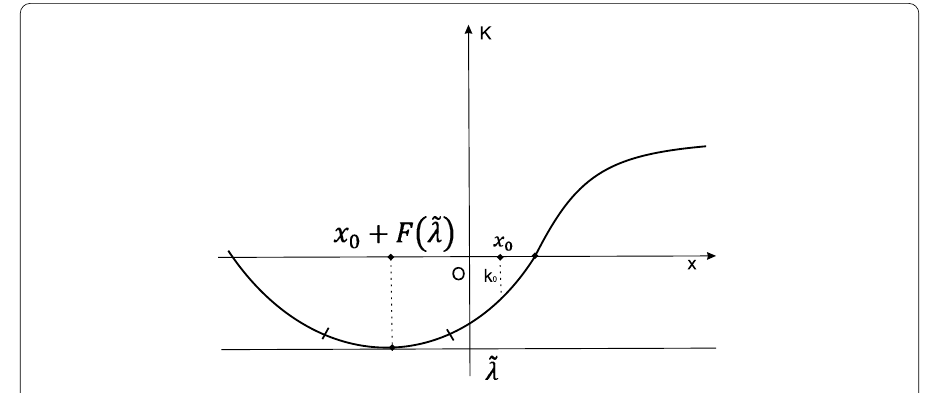
Figure 4 The graph of the function k = k ( x ) satisfying Eq. (33) has a logarithmic growth at infinity and horizontal tangent at x 0 + F ( ˜ λ